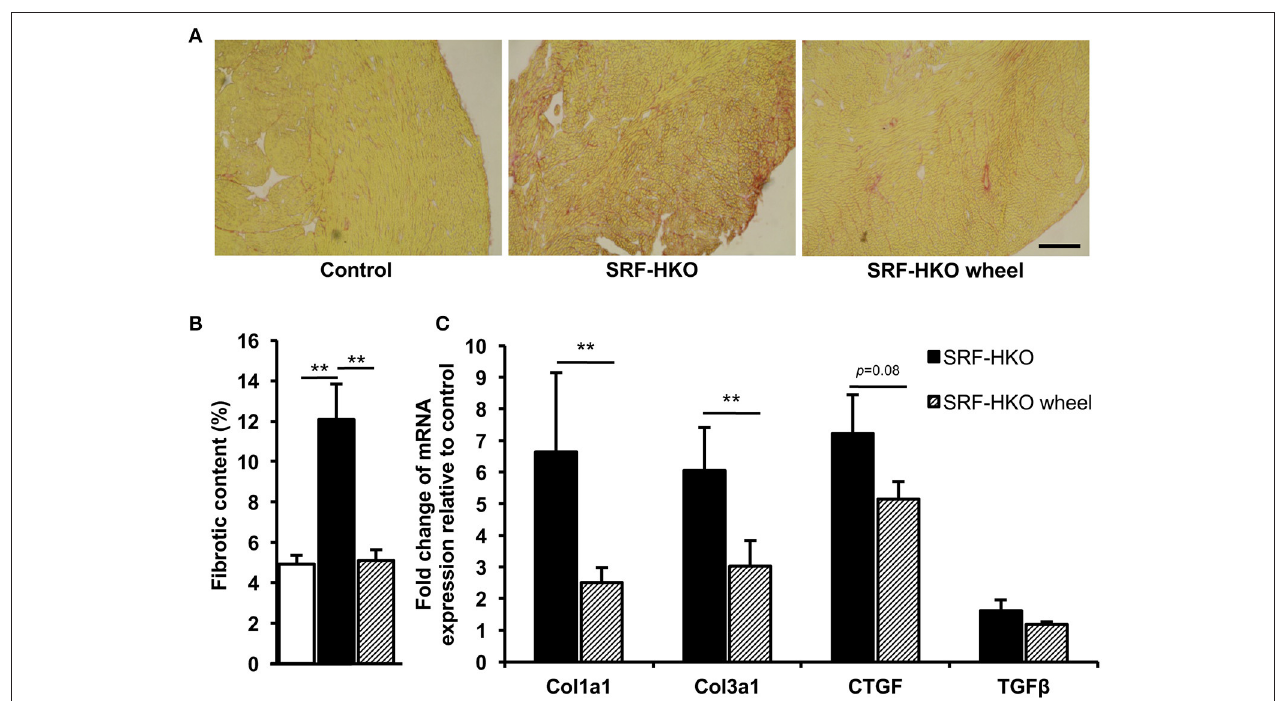
FIGURE 2 | Myocardial fibrosis quantification by PicroSirius Red staining (A,B) and real-time PCR analysis (C). (A,B) PicroSirius Red staining of transverse myocardium sections (A) and histogram representation (B) of fibrotic content in control ( n = 3), SRF-HKO ( n = 5) and SRF-HKO wheel ( n = 6) mice. (C) Relative quantification by real-time PCR of collagen I (Col1a1), collagen III (Col3a1), connective tissue growth factor (CTGF) and transforming growth factor beta (TGF β ) mRNA levels in myocardial tissue. Results are presented in-terms of a fold change to control after normalizing with Hmbs mRNA. The control mice value is set at 1.0. Results are expressed as mean values ± SEM. ** p < 0.01. Scale bar = 200 µ